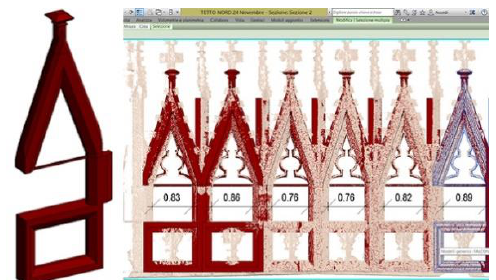
Figure 6. The Falconatura as it appears in the family editor, with some bonds that make it parametric and adjustable on the point